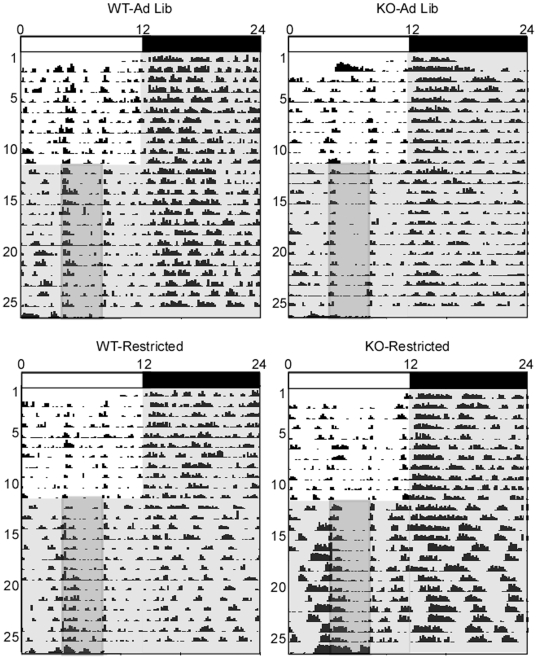
Representative actograms of WT and KO mice under ad libitum feeding conditions or a restricted feeding schedule conducted in constant dim red light.All animals were initially housed in a standard light/dark cycle (indicated by white/black bars above) with ad libitum food access, then switched to constant dim light (indicated by gray shading) at ZT12 the day prior to the start of the restricted feeding schedule. The restricted feeding schedule and corresponding time window for ad libitum-fed control are indicated by dark gray shading.